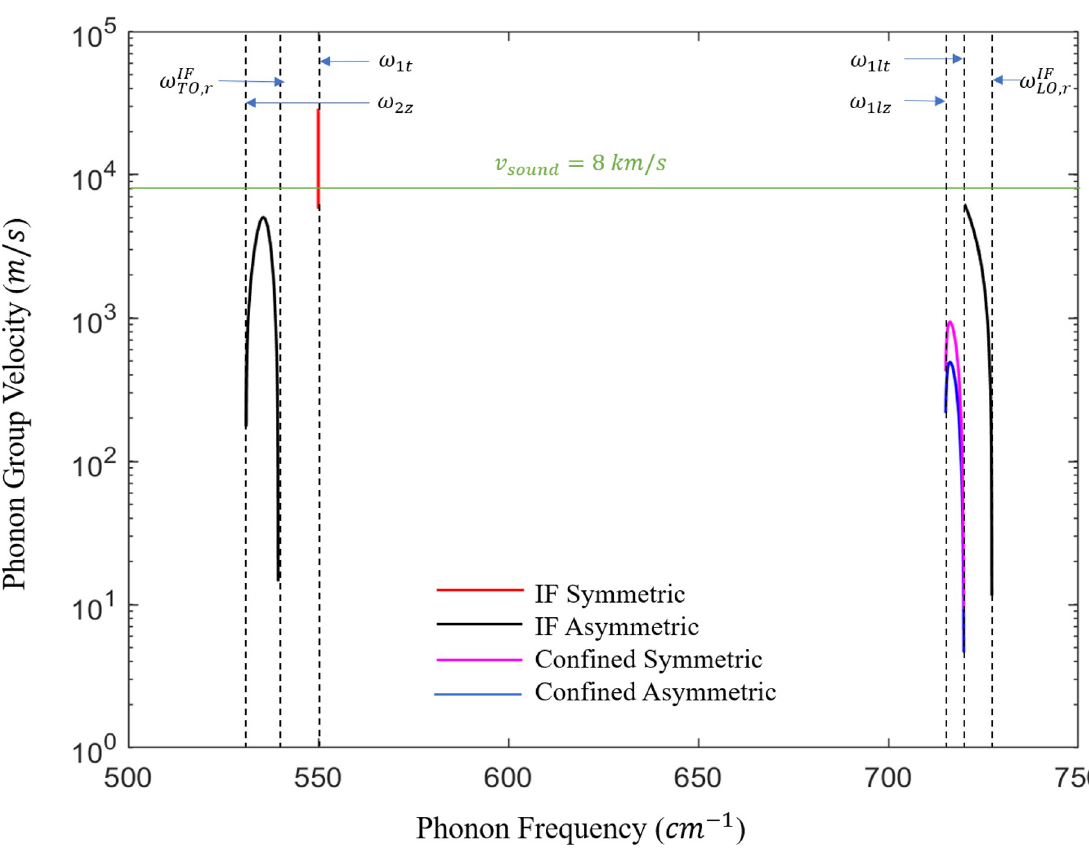
Fig 6. The group velocities of the IF and confined phonons against the phonon frequencies for the case of InGaN well of d = 5 nm. Only the modes in the intervals [ ω 2 , ω 1 ] and ½ o ; o IF � which show significant group velocities are plotted. The symmetric IF (confined) z t 1 lz LO ; r phonons are plotted in red (magenta) and the asymmetric IF (confined) phonons are plotted in black (blue). For both modes, the group velocity is referenced to the acoustic sound velocity highlighted in green. Only the first confined mode is considered in the LO region for each symmetric and asymmetric mode. The resonance frequencies along with the system’s characteristic frequencies are shown by the horizontal blue